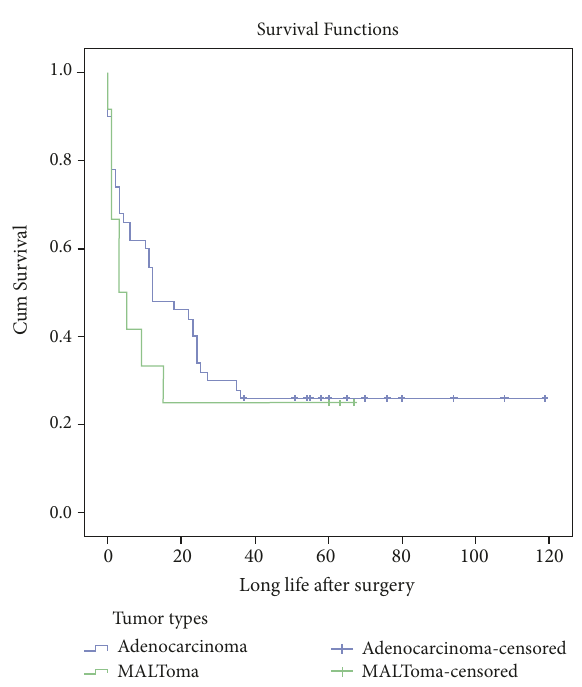
Figure 2: Kaplan-Meier curve illustrating overall survival of adeno- carcinoma (n=78) compared with other types of tumors